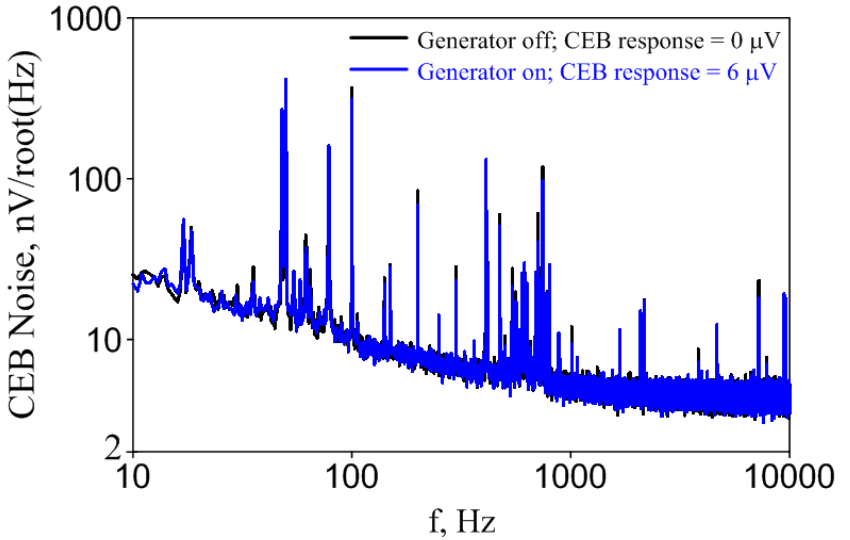
Figure 5. Voltage noise of CEB under the influence of YBaCuO signal and in the absence of external GHz radiation. GHz